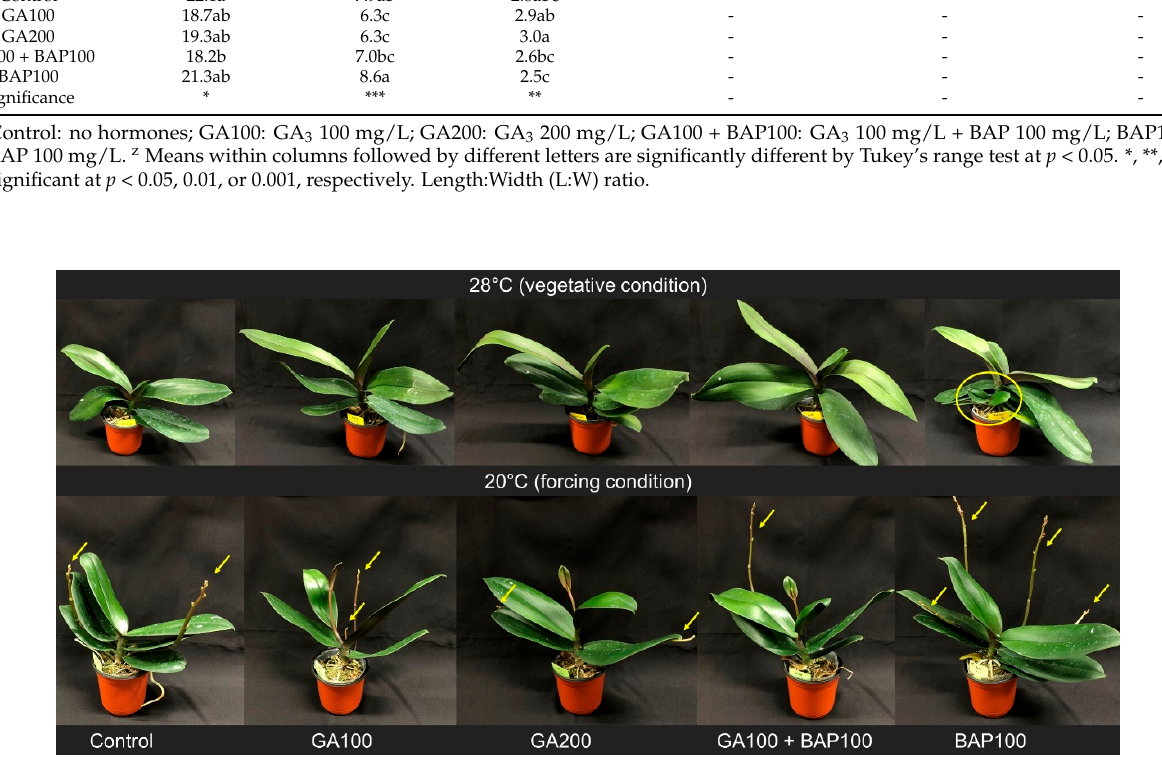
Figure 1. Growth and inflorescence emergence of Phalaenopsis Queen Beer ‘Mantefon’ plants treated with exogenous gibberellic acid 3 (GA 3 ) and 6-benzylaminopurine (BAP) at either 28 °C (vegetative condition) or 20 °C (forcing condition) for